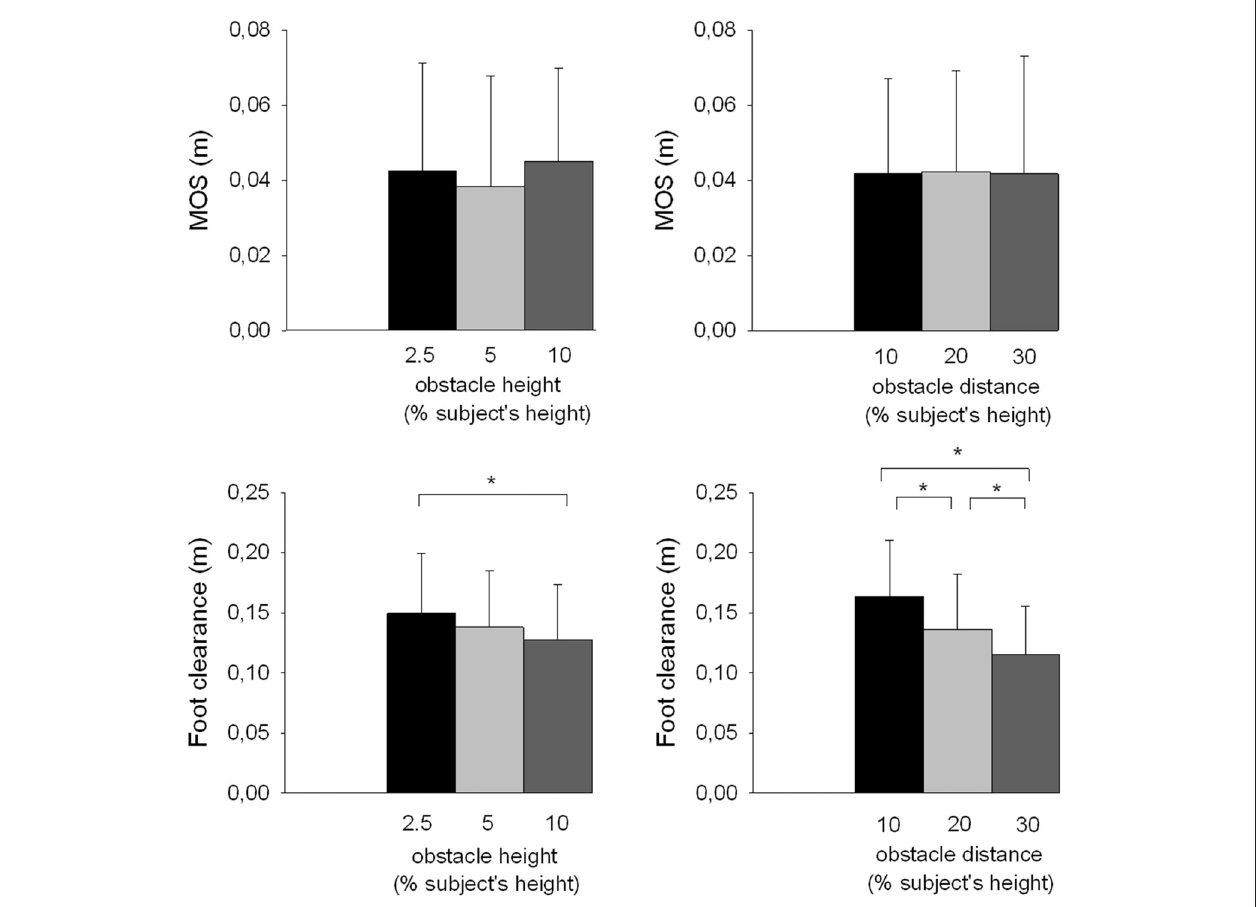
FIGURE 4 | Effects of obstacle height and distance on stability parameters. Reported are mean values (all participants together) ± 1 SD. MOS, margin of stability. ∗ Indicates a significant difference between